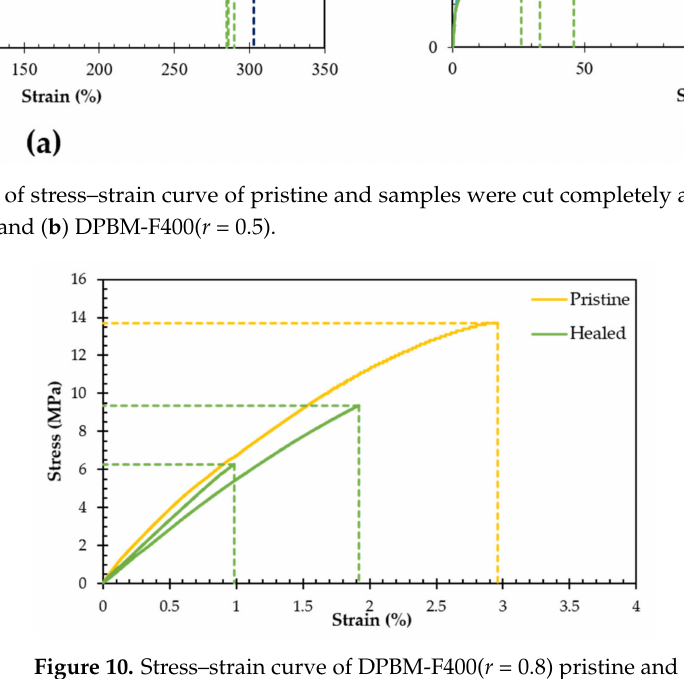
Figure 10. Stress–strain curve of DPBM-F400( r = 0.8) pristine and samples were cut completely and healed for 1 h at 90 ◦